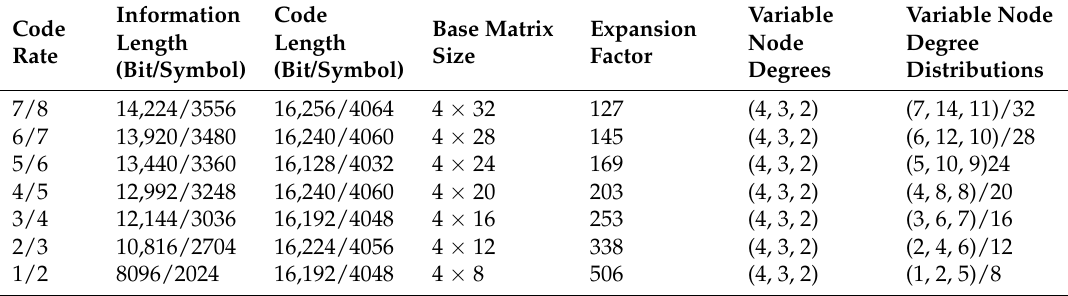
Figure 12. RC-LDPC base matrix scatter diagram. Table 3. Parameters of the designed RC-NB-LDPC